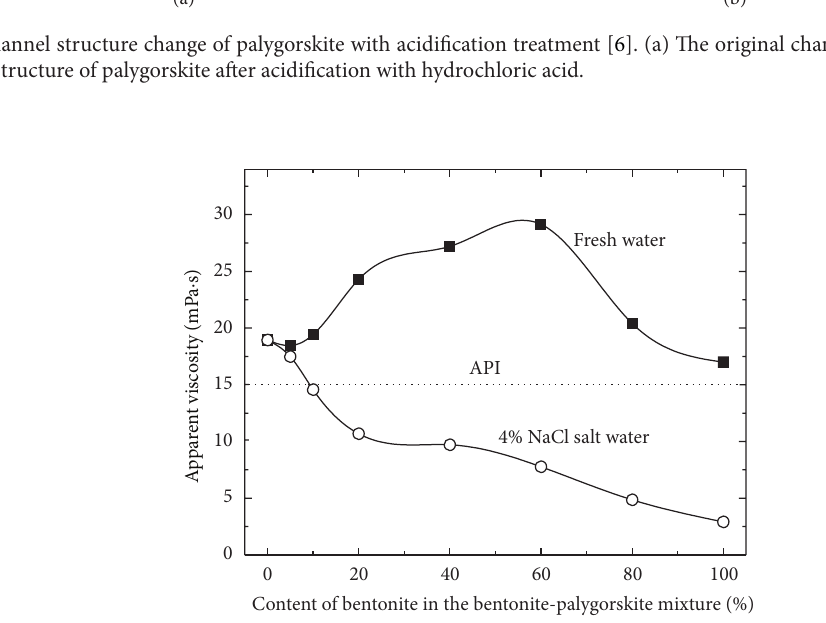
Figure 3: The effects of bentonite addition on the viscosity of suspension of bentonite-palygorskite mixture in fresh water and salt water.